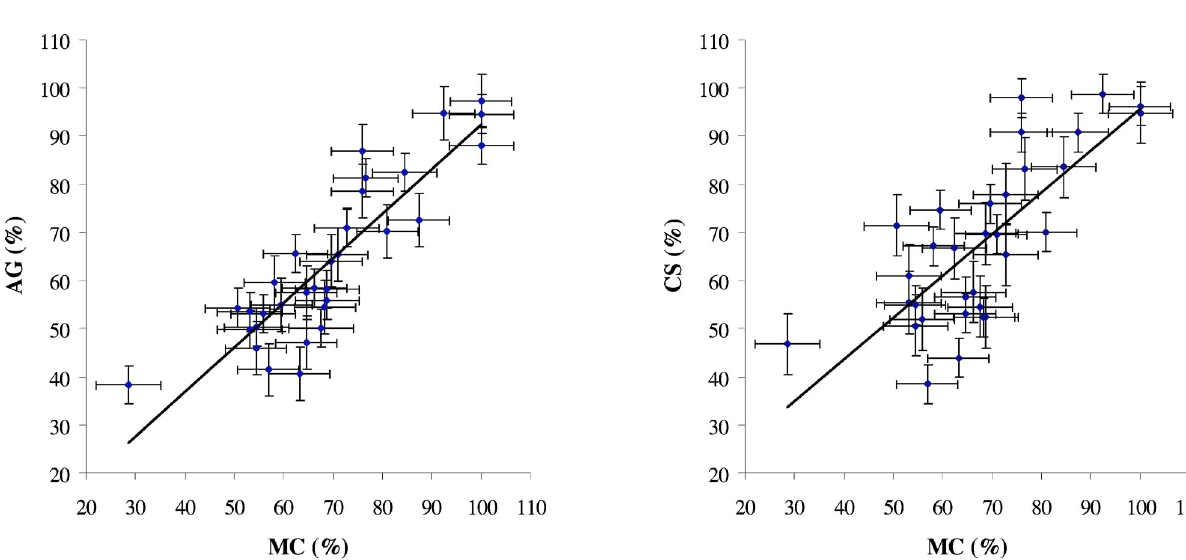
FIG. 7. (cid:1) Color (cid:2) The raw data from the students involved in the validity study (cid:1) N =33 (cid:2) . The graph is a plot of the students’ commit- tee score (cid:1) CS (cid:2) versus their multiple-choice score (cid:1) MC (cid:2)